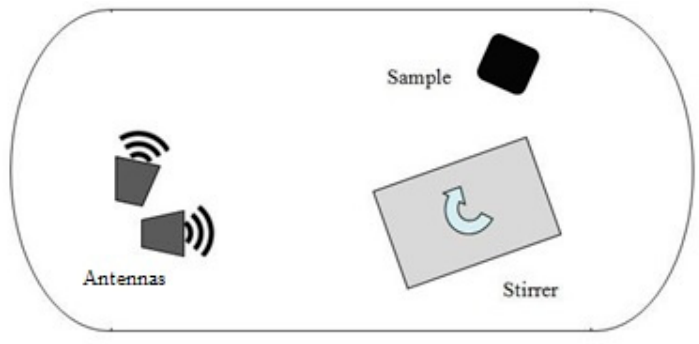
Figure 6. Schematic of the reverberation chamber set-up inside.